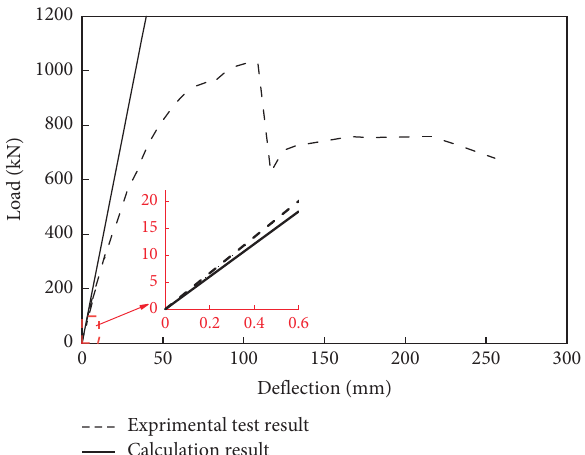
Figure 12: Comparisons between the FE results and experimental results.